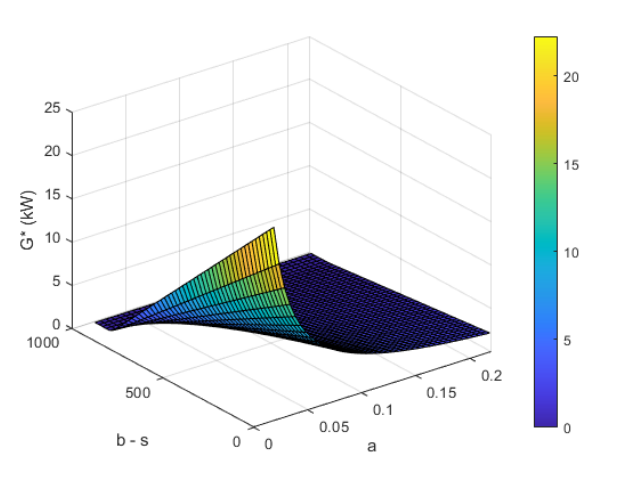
Figure 1. Installing capacity of solar PV for regional-level